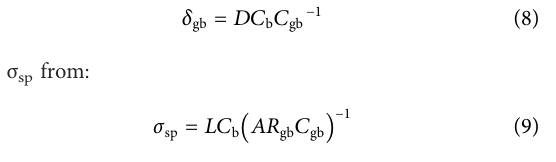
FIGURE 8 (A) Equivalent circuit comprising a (upper) branch for transport along grain boundaries (parallel to the current fl ow) and another (bottom) branch for transport along grains in series with grain boundaries (perpendicular to the current fl ow); (B) Brick-layer model scheme of a ceramic with grain size D and grain boundary thickness δ gb , highlighting relationships between volume and